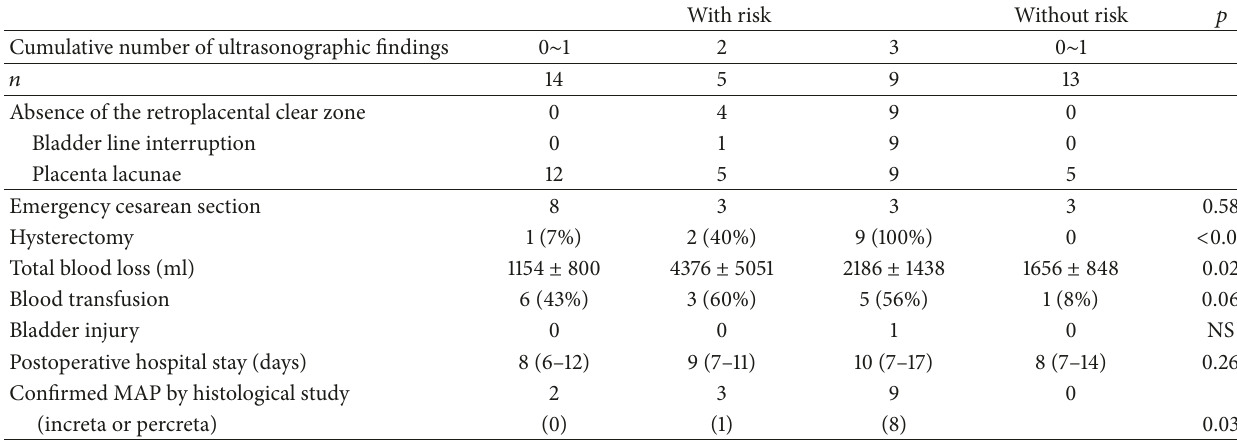
Table 2: Maternal outcomes according to ultrasonographic findings. Results are expressed as number, mean ± SD, or incidence (%). Comparisons between groups were made using Welch’s 𝑡 -test. Comparisons among groups were made using the Kruskal-Wallis test or 𝜒 2 tests. NS: not